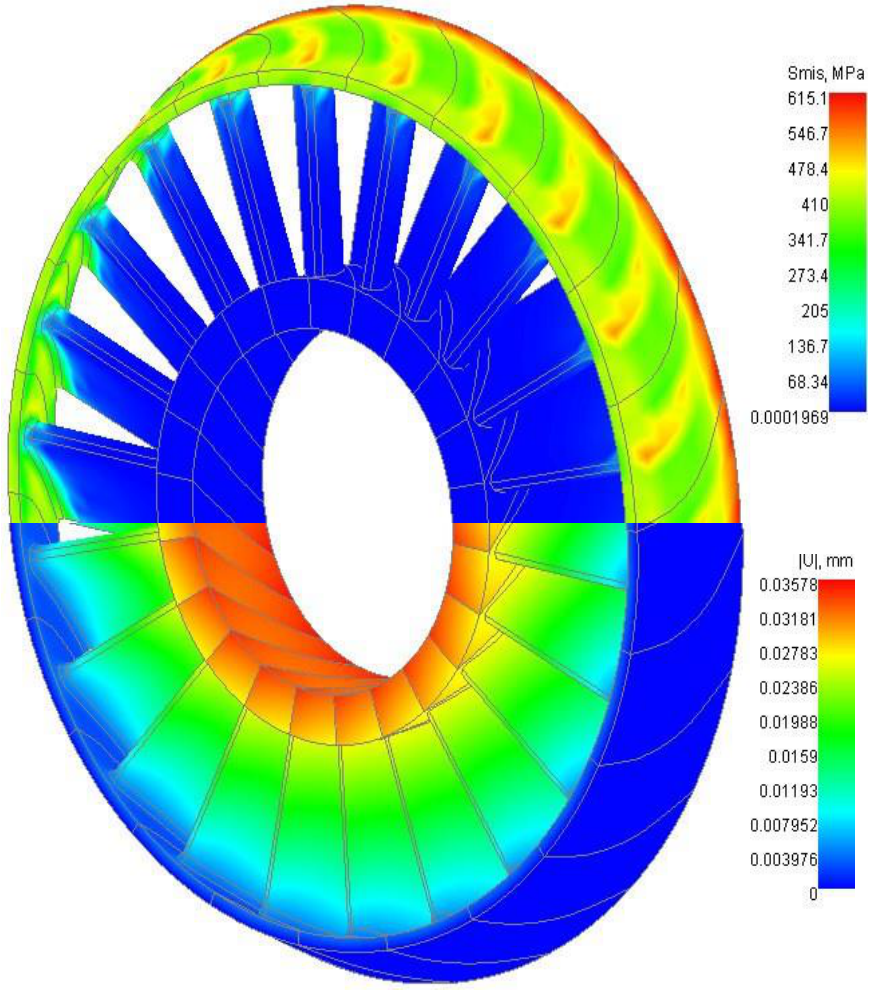
Figure 47. Stator blades’ von Mises stress distribution ( top ) and displacement ( bottom ) scenes.